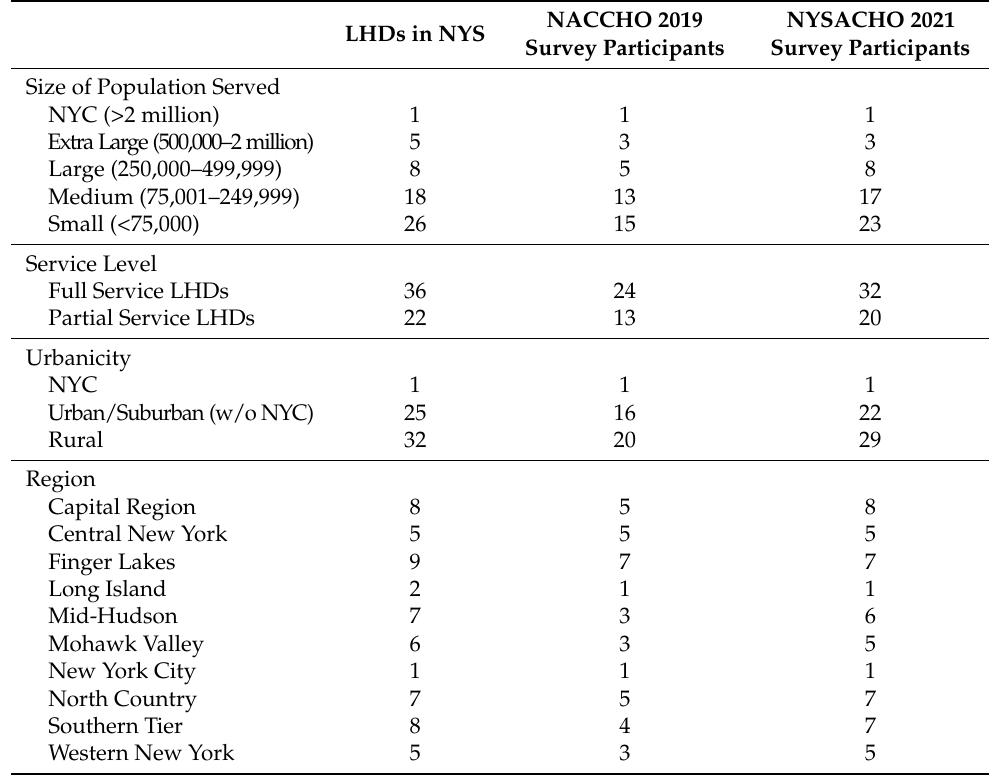
Table 1. All LHDs in NYS vs. LHDs that Completed the NYSACHO 2021 Enumeration Survey.